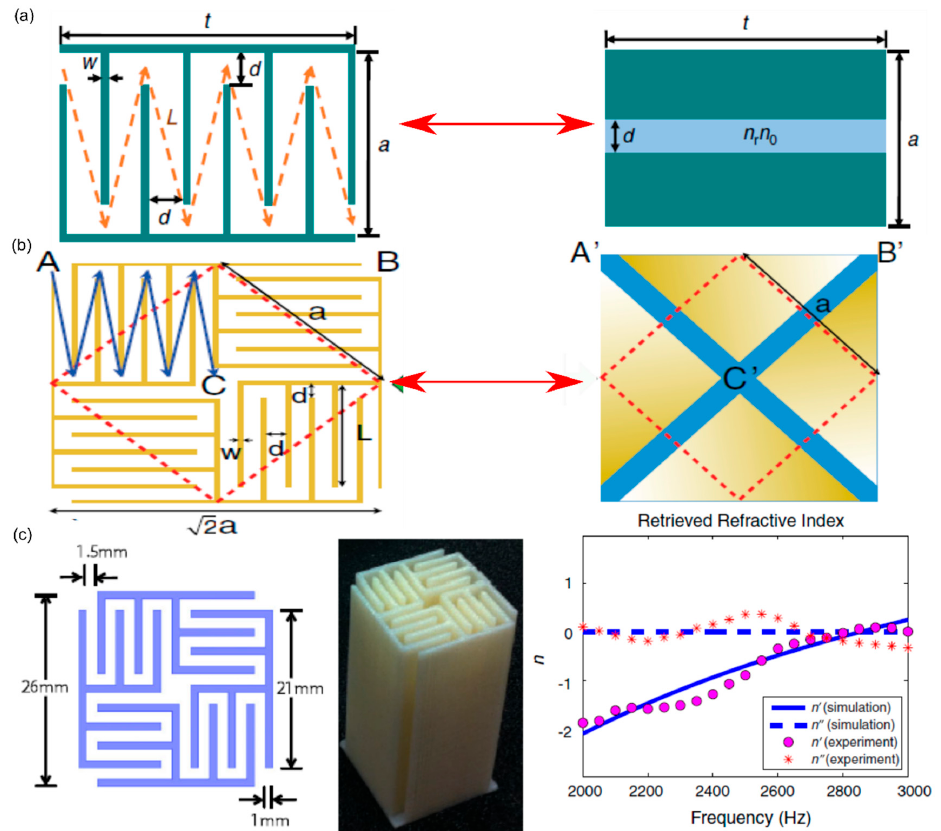
Figure 2. ( a ) Schematic illustrations of the traditional labyrinthine-type space-coiling metamaterial unit cell with the overall length of t and overall width of a . Also, d and w are channel width and coil wall thickness, respectively, and L is the acoustic wave trajectory (represented by the dashed line) length within each coil. The equivalent model featuring a single straight channel filled with a medium of different refractive index is shown. The relative refractive index can be expressed as n r = L ef f / t , where L ef f = N × L is the e ff ective total channel length. Here, N denotes the number of coils. Reprinted with permission from Gha ff arivardavagh et al. [80], licensed under a Creative coiling-up-space metastructure consisting of thin plates of length L and thickness d arranged in folded channels of width d and lattice constant a . The zigzag blue arrows denote a path of waves in the second quadrant inside curled channels—the simplified view with straightened channels (‘‘X’’- shaped region). Reprinted with permission from Liang and Li [71] , © 2020 American Physical Society.